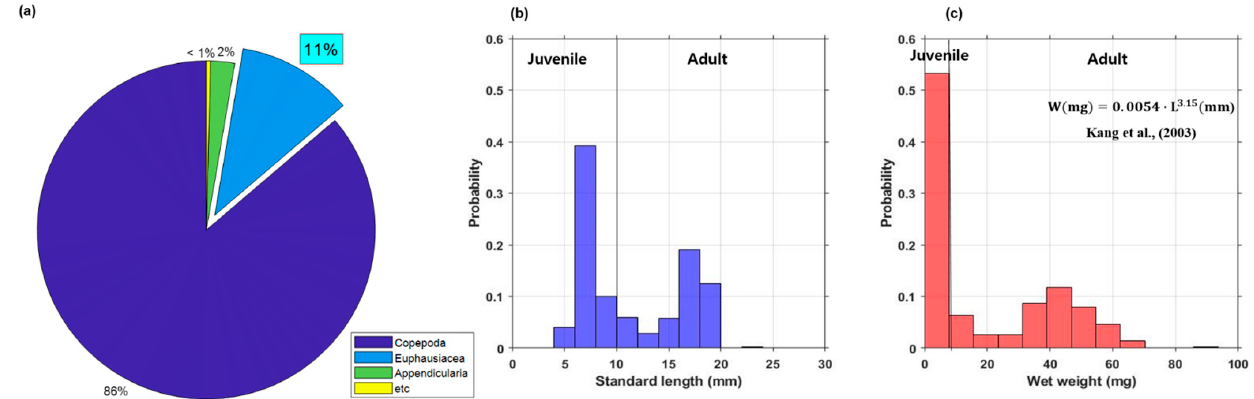
Figure 3. ( a ) Zooplankton species composition from net sampling data and the histograms of the ( b ) standard length ( L ) frequency distribution and ( c ) wet weight ( W ) frequency distribution from all net surveys of E. pacifica in the